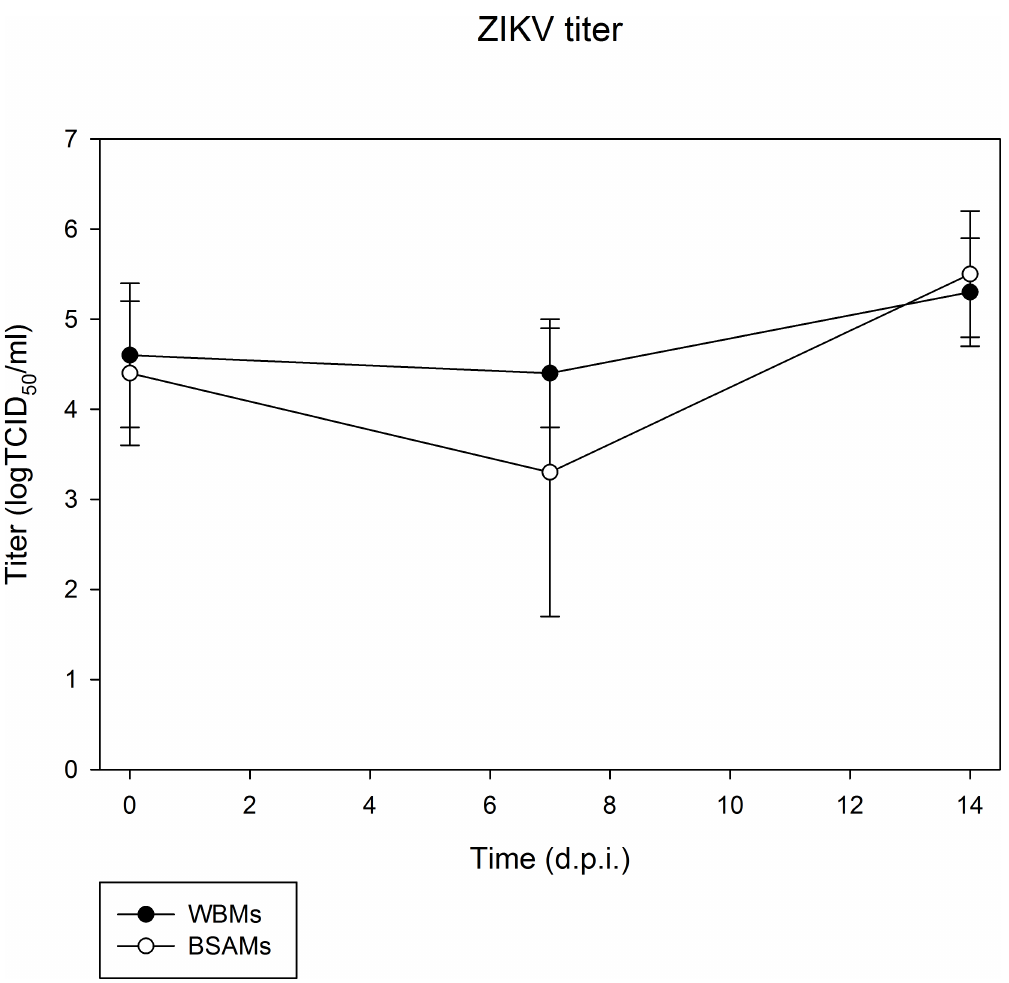
Fig 1. Titers of ZIKV in Ae . aegypti orally challenged with infectious WBMs and BSAMs. Average titers of infected wholemosquitoesat 0, 7 and 14 d.p.i. from Ae . aegypti receivinginfectiousWBMs and BSAMs are shown in solid circle and open circle,